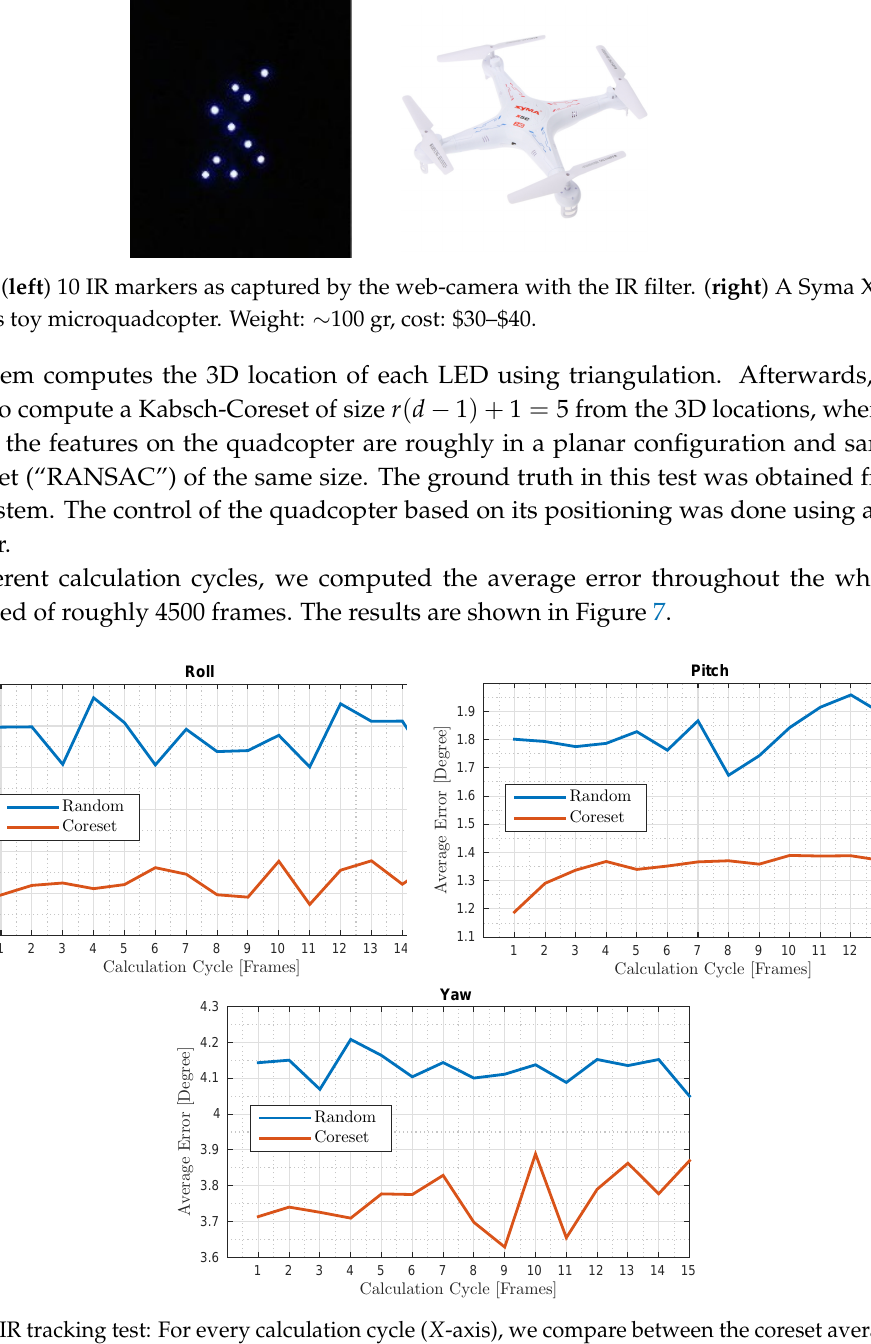
Figure 7. IR tracking test: For every calculation cycle ( X -axis), we compare between the coreset average error and the uniform random sampling average error. The Y -axis shows the whole test average error for each calculation